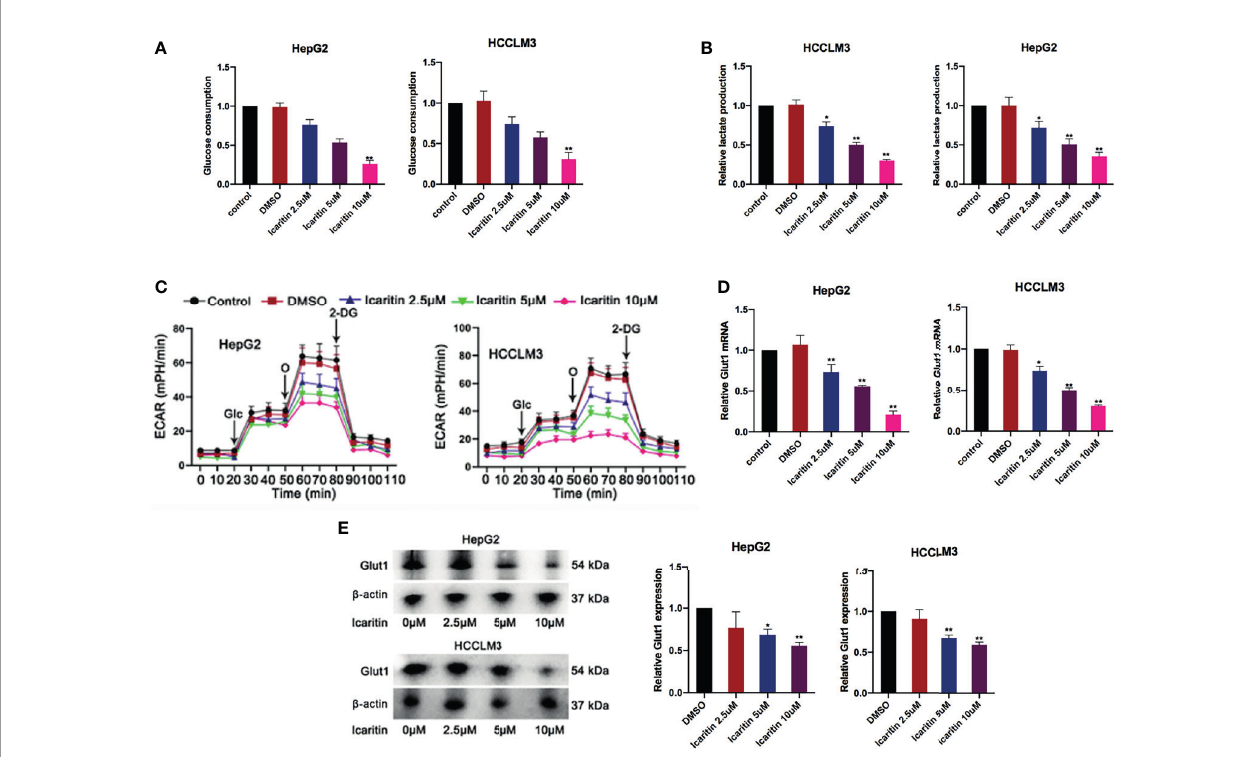
FIGURE 2 | Icaritin reduced GLUT1 and moderated the Warburg effect in HCC cells. (A, B) Glucose consumption and lactate production ef fi ciency of HCC cells were detected after the treatment of icaritin of different concentrations. (C) ECAR of HCC cells with the treatments of different concentrations icaritin. (D, E) The mRNA and protein level of GLUT1 in HCC cells was detected after the treatment of different concentrations icaritin. * p < 0.05, ** p <